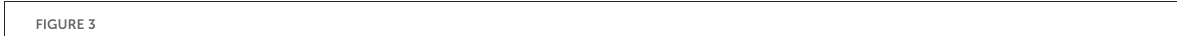
FIGURE3 showing immunofluorescence staining of endothelial (CD31) and cell adhesion (ICAM-1) markers in males (A) and females (C) . The dotted yellow, and green lines contour the aortic root section, and neointima layers, respectively. The scale bars represent 50 µ m unless otherwise indicated. (B,D) Box plots showing quantification of total (left panels), and neointimal (right panels) ICAM-1 in males (B) and females (D) . Total ICAM-1 was calculated as ICAM-1 area in entire root/root area. Neointimal ICAM-1 was calculated as area of ICAM-1/neointimal area. Dots represent individual animals and the number of animals per group is indicated in parentheses. Statistical significance was determined by Wilcoxon Rank Sum Test with Bonferroni correction. * p <